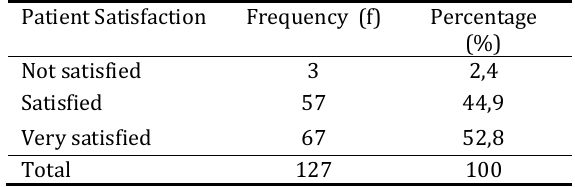
Table 2 Respondent Frequency Distribution Based on Patient Satisfaction in the ward on December